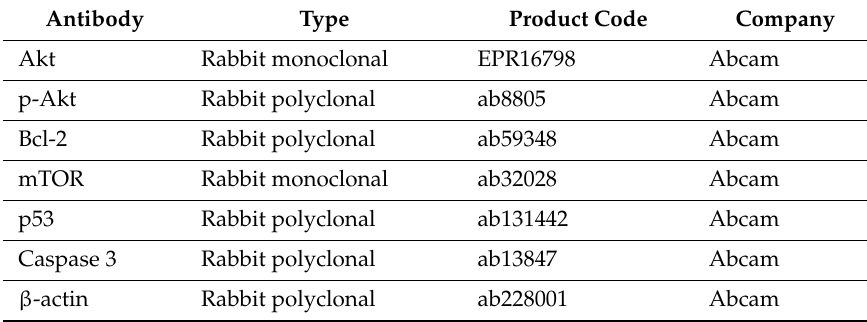
Table 1. Antibodies used in the current